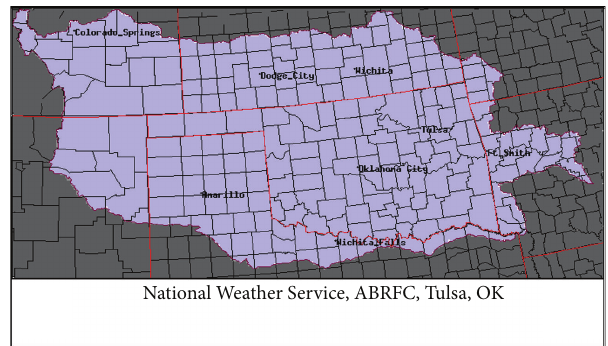
Figure 2: The Arkansas-Red River Basin. Image from the National Weather Service River Forecast Center: Arkansas-Red Basin [20].